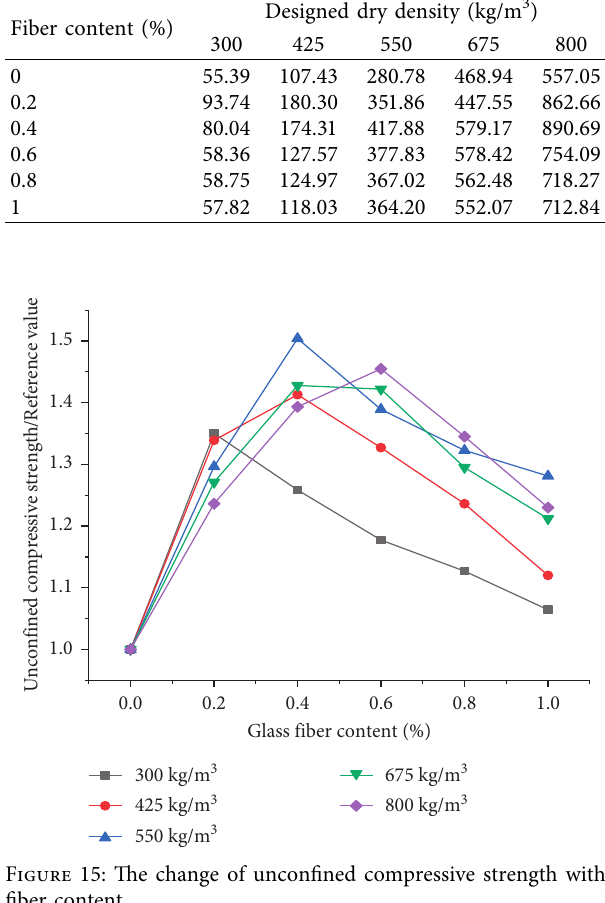
Figure 15: The change of unconfined compressive strength with fiber